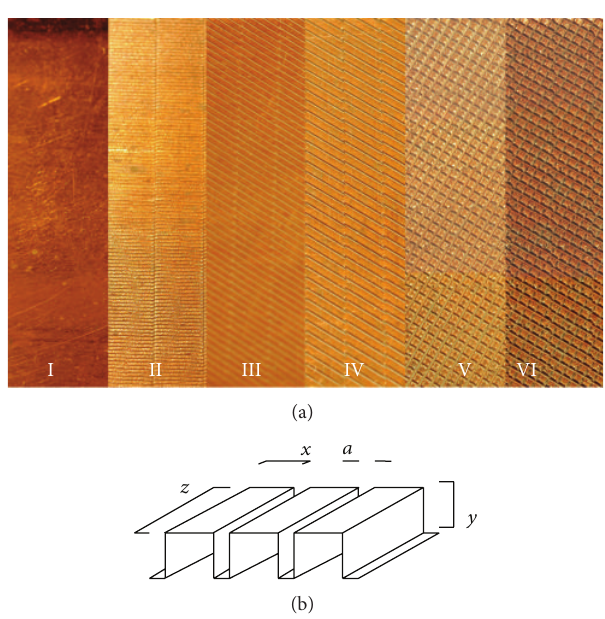
Figure 2: Schematic and photos of different areas of copper substrate.